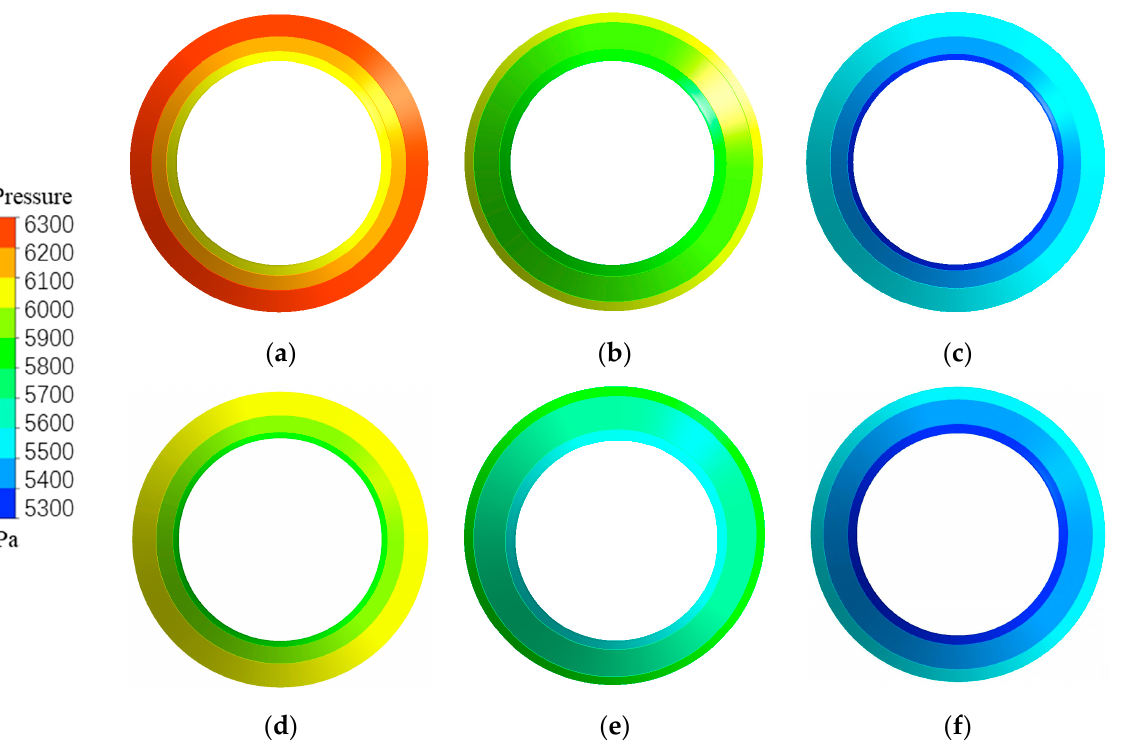
Figure 8. Static pressure distributions in the diffuser of original and optimized fans: ( a ) optimize diffuser 0.8 Q; ( b ) optimize diffuser Q; ( c ) optimize diffuser 1.2 Q; ( d ) original diffuser 0.8 Q; ( e ) original diffuser Q; ( f ) original diffuser 1.2 Q.